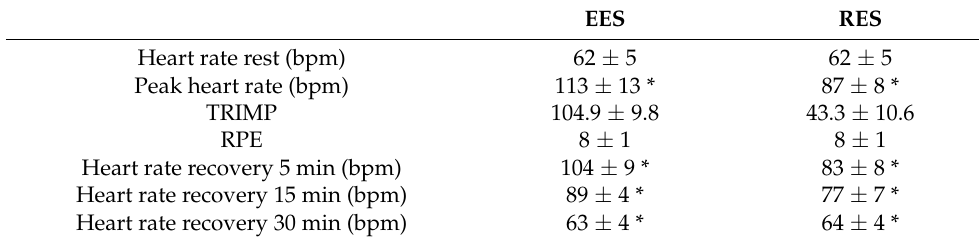
Table 2. Heart rate session variables.